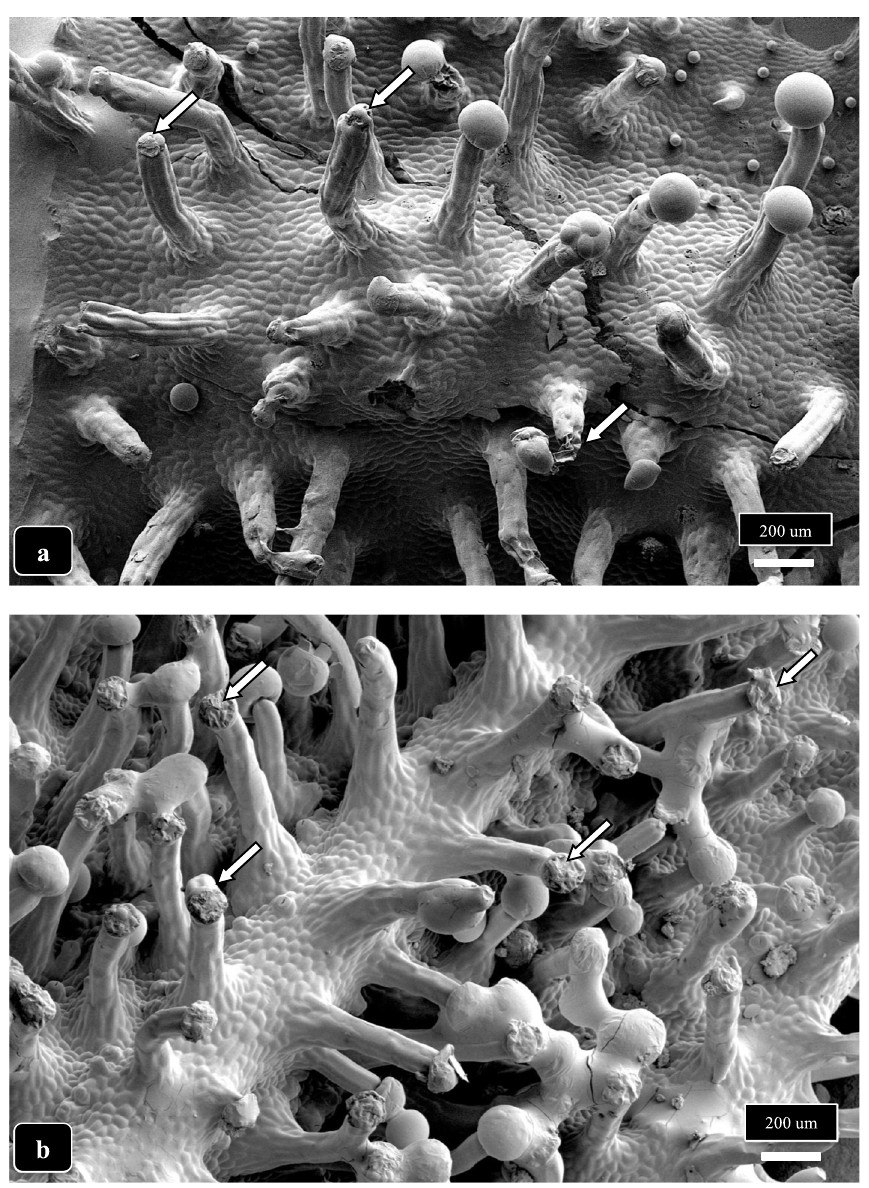
Fig. 12 The occurrence of a large number of senescent capitate glandular heads on 8 week old bracts of cannabis genotypes MD ( a ) and SQ ( b ) is shown. In both samples, the glandular heads appear shriveled and shrunken, indicating a loss of resin has occurred (arrows)